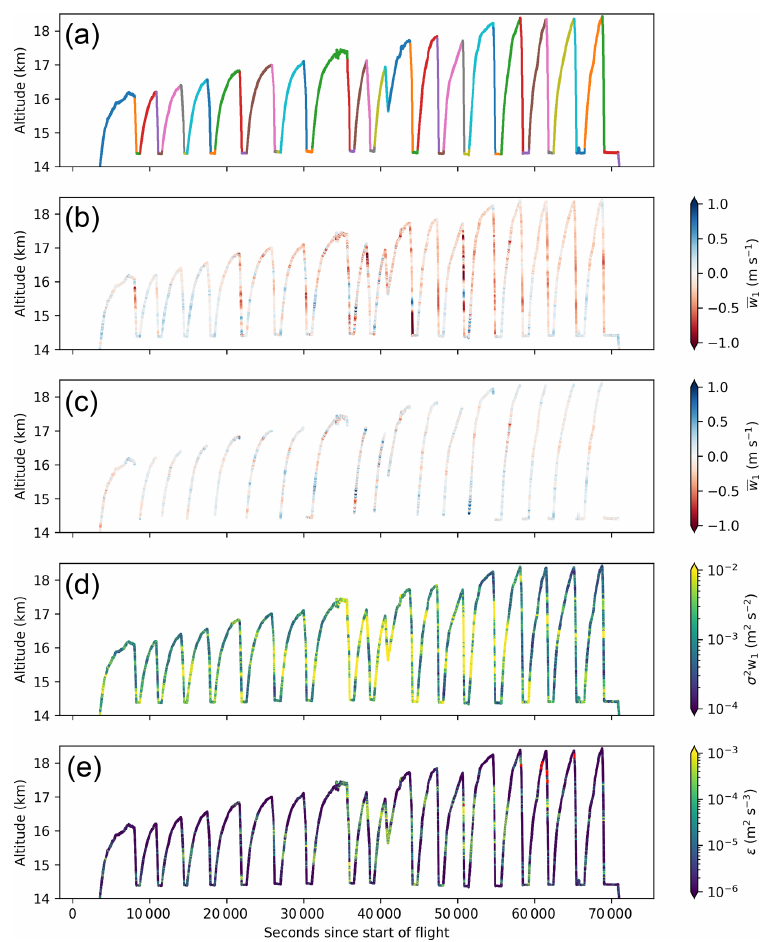
Figure A1. Flight tracks from a flight during ATTREX 2014 shown in time–height space, with the color indicating (a) different flight legs, (b) uncorrected mean 1s vertical wind ( w 1 ), (c) corrected w 1 , (d) high-frequency ( > 1Hz) vertical wind variance ( σ 2 w 1 ), and (e) turbulent eddy dissipation rate ( (cid:15) ). Outliers in (cid:15) are shown in red.